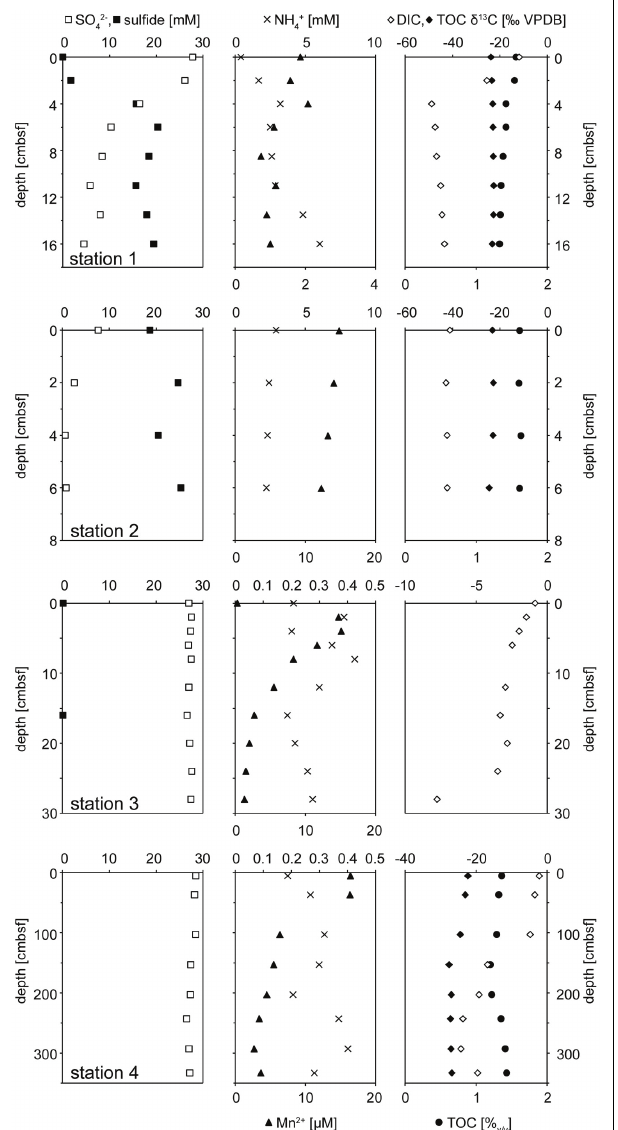
2 × 10 8 cells cm − 3 for Bacteria and 4 × 10 7 cm − 3 for Archaea at the station 2. At the stations 3 and 4, CARD–FISH indicated no living archaeal cells ( Figure 4